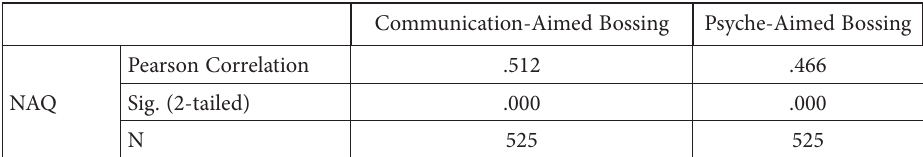
Table 5. Correlations of the BOSS and NAQ factors